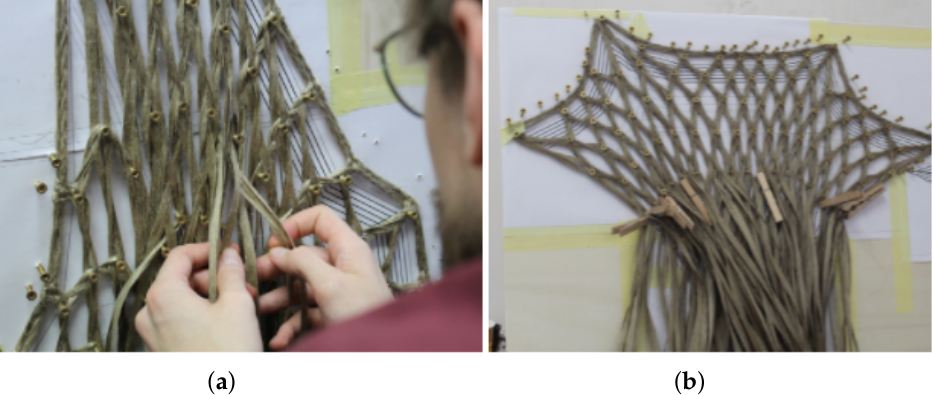
Figure 13. The bobbin lacing process ( a ) Creating a node by hand. ( b ) In process template, showing a partially completed